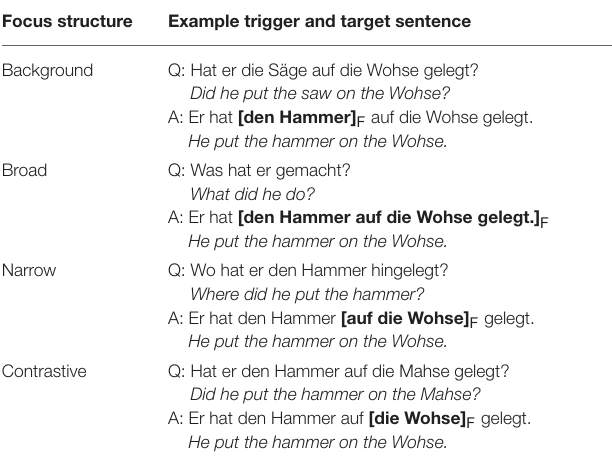
TABLE 1 | Example question-answer-pairs to elicit the focus